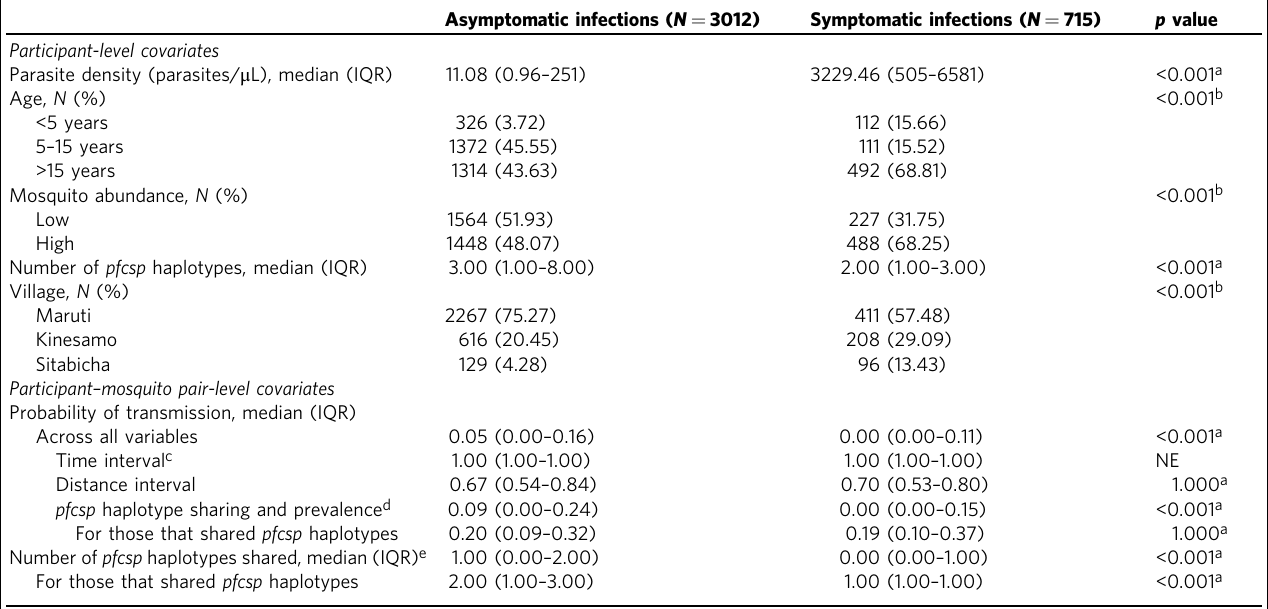
Table 1 Comparison of pairings of participant and mosquito infections by symptomatic